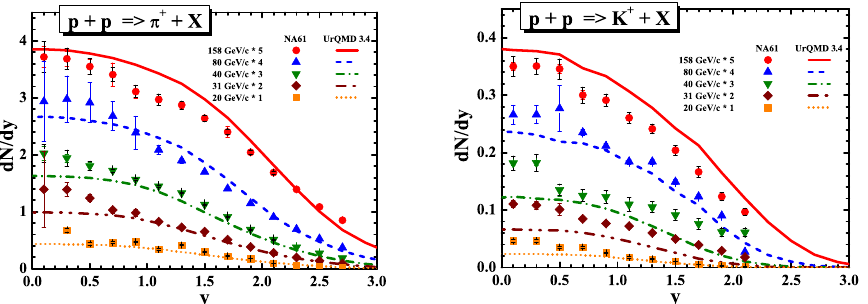
Figure 1. The UrQMD v3.4 predictions (lines) for the rapidity distributions of π + (left) and K + (right) mesons produced in inelastic p + p interactions at beam momenta of 20, 31, 40, 80 and 158 GeV / c in comparison to experimental data from the NA61 / SHINE Collaboration (symbols)